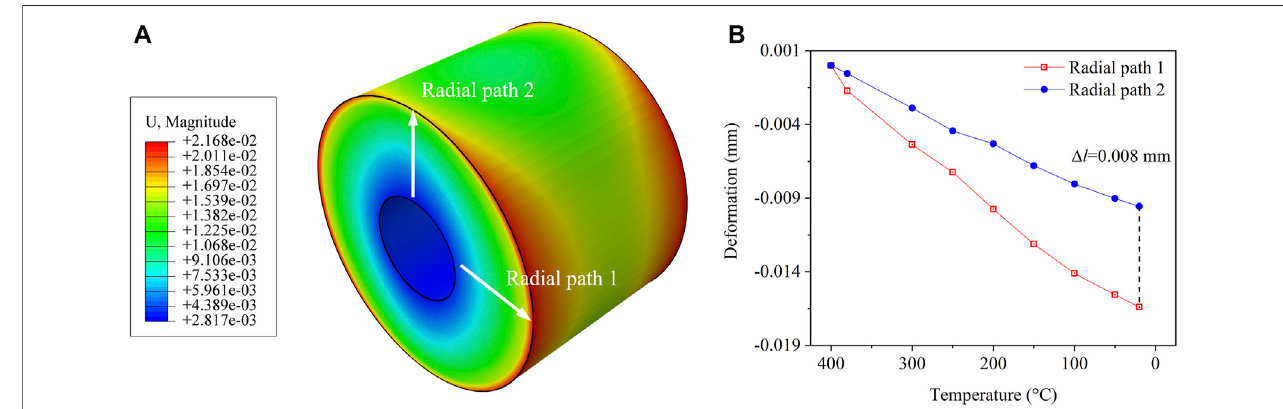
FIGURE 9 | (A) Contour of the asymmetric deformation of the designed model; (B) deformation along two radial paths in glass with the thickest and the thinnest metal shell.